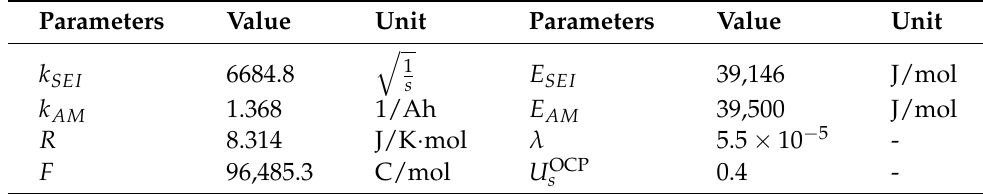
Table 3. Coefficients of the simplified reduced-order